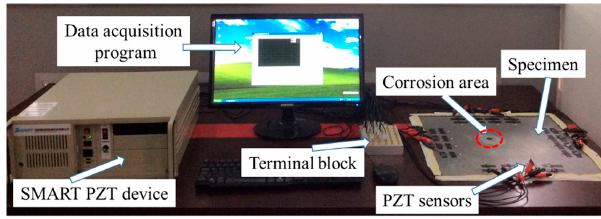
Figure 8. The experimental setup.